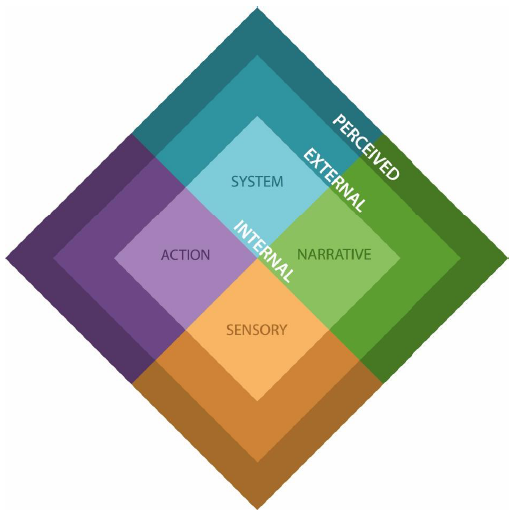
Figure 1. Model of the types of realism associated with digital games (inner square: internal realism; second square: external realism; outer square: perceived realism; dimensions: system, narrative, ac- tion, sensory).